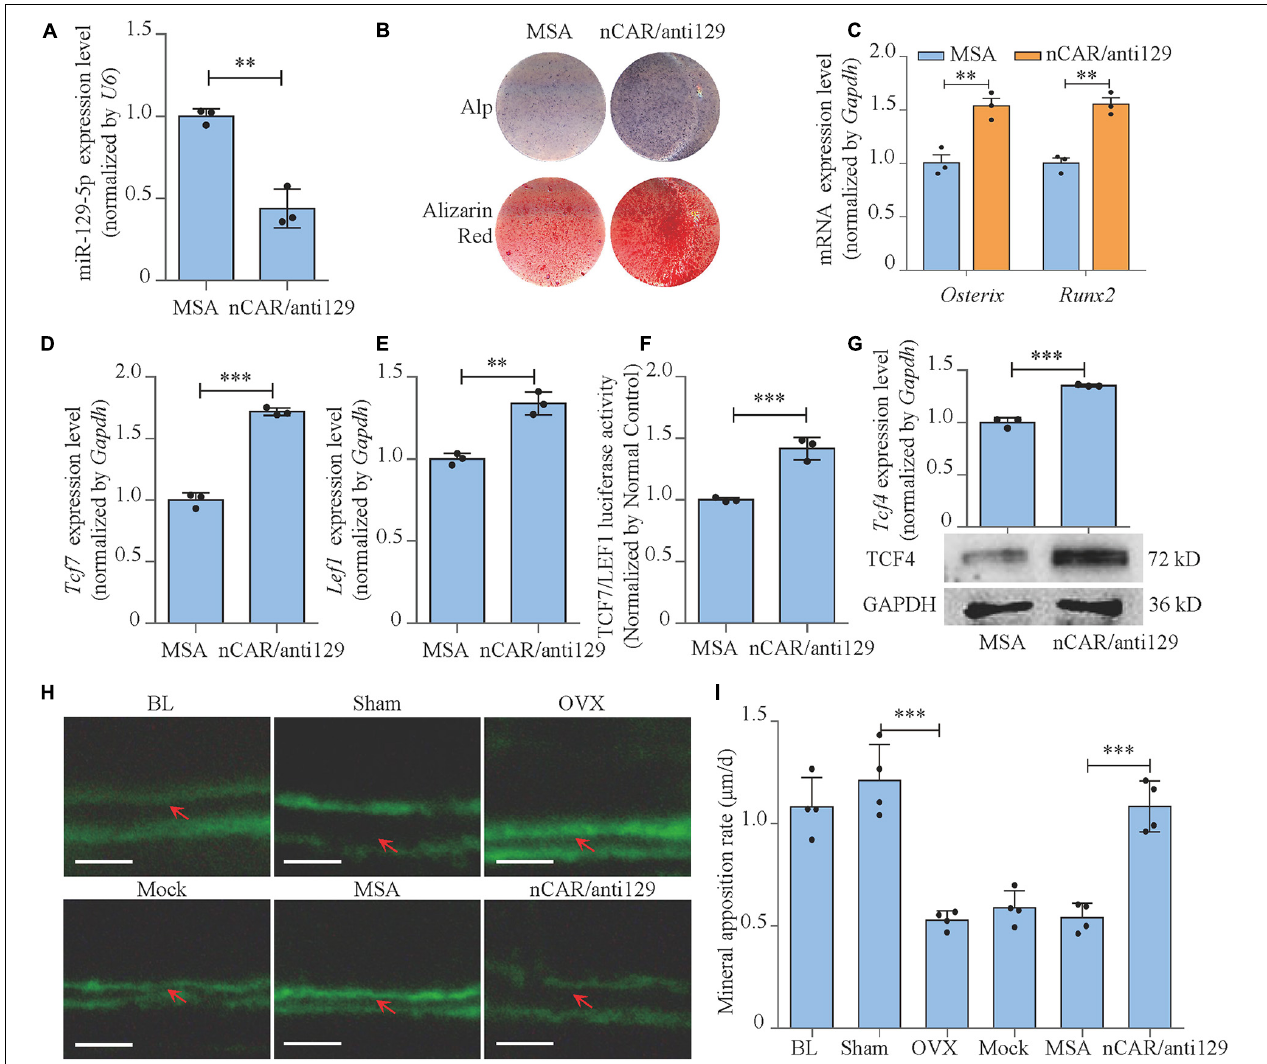
FIGURE 8 | Bioengineered recombinant miR-129-5p inhibitor enhanced osteoblast differentiation and rescued postmenopausal osteoporosis. (A) miR-129-5p expression levels of MC3T3-E1 cells treated with recombinant miR-129-5p inhibitor, as detected by reverse transcriptase-polymerase chain reaction (RT-PCR; mean ± SD, ∗∗ P < 0.01). MSA: tRNA Met fused Sephadex aptamer. nCAR/anti129: novel recombinant miR-129-5p inhibitor. (B) Alp and alizarin red staining of MC3T3-E1 cells treated with recombinant miR-129-5p inhibitor, as detected by Alp staining and alizarin red staining. Alp: results of Alp staining. alizarin red: results of alizarin red staining. (C) Osterix and Runx2 expression levels of MC3T3-E1 cells treated with recombinant miR-129-5p inhibitor, as detected by RT-PCR (mean ± SD, ∗∗ P < 0.01). (D,E) Tcf7 and Lef1 expression levels of MC3T3-E1 cells treated with recombinant miR-129-5p inhibitor, as detected by RT-PCR (mean ± SD, ∗∗ P < 0.01, ∗∗∗ P < 0.001). (F) TCF7/LEF1 activities of MC3T3-E1 cells treated with recombinant miR-129-5p inhibitor, as detected by luciferase reporter assay (mean ± SD, ∗∗∗ P < 0.001). (G) TCF4 expression levels of MC3T3-E1 cells treated with recombinant miR-129-5p inhibitor, as detected by RT-PCR and